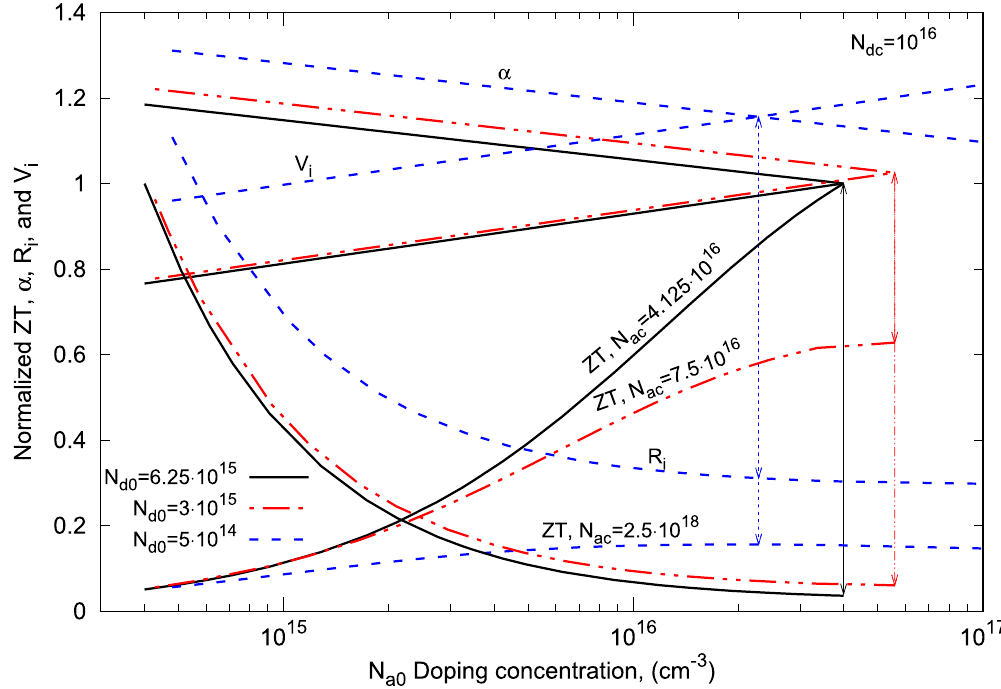
Figure 5. Thermoelectric transport properties, α , resistance, ZT, and V i vary with the p -type leg doping density for three typical n -type leg doping